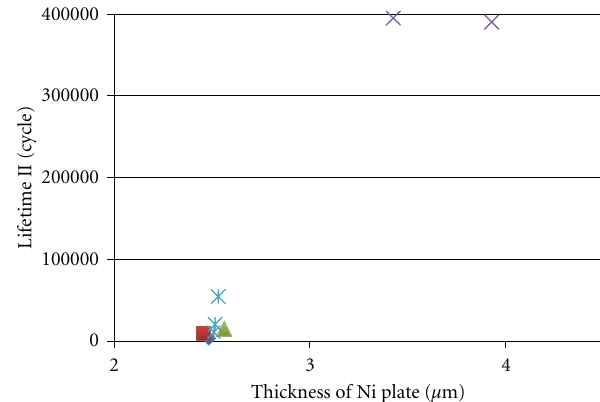
Figure 14: E ff ect of thickness of nickel interlayer.